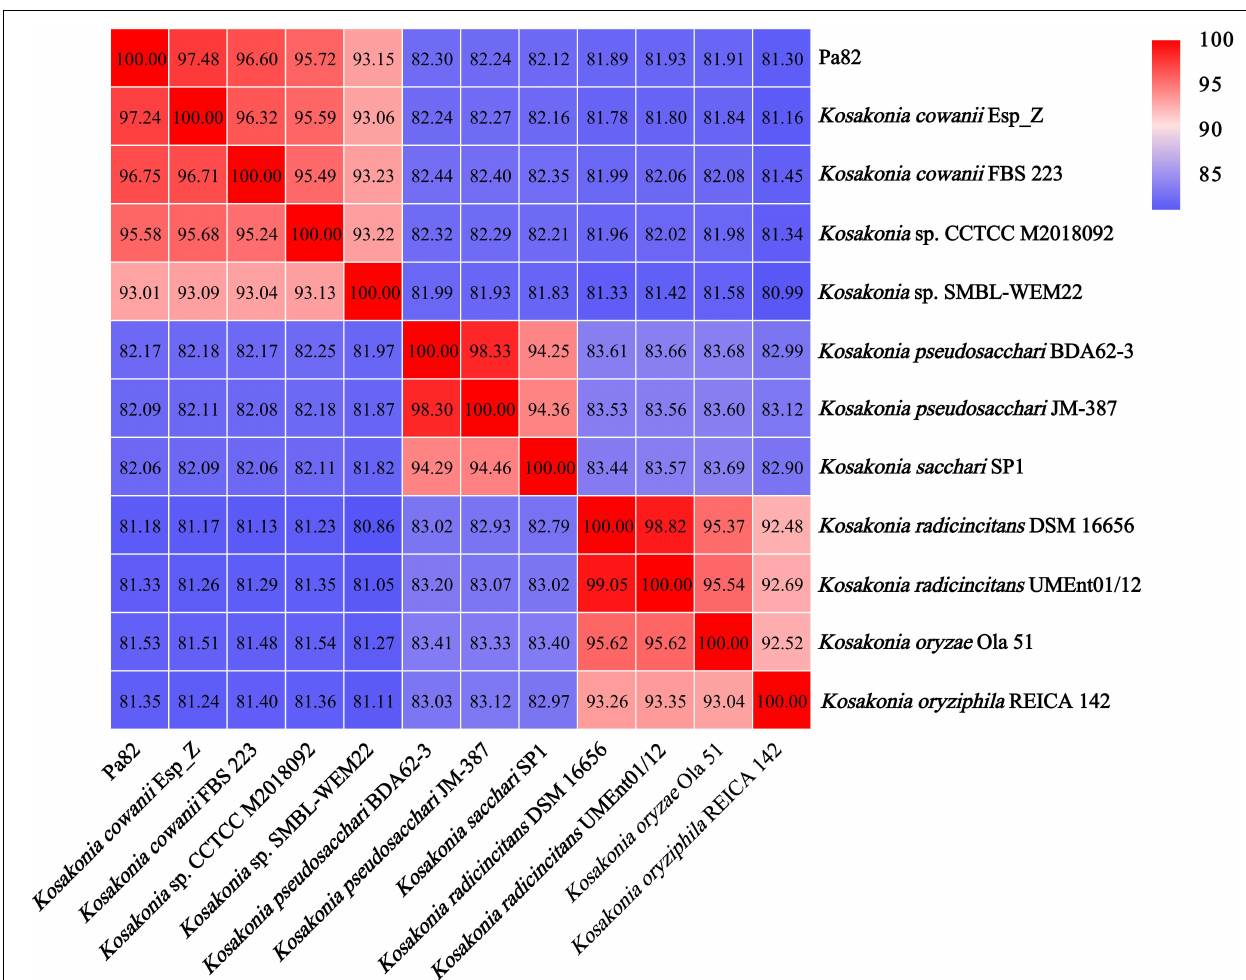
FIGURE 5 | Heat map based on average nucleotide identity (ANI) values between each pair of genome sequences from strain Pa82 and strains within genus Kosakonia .